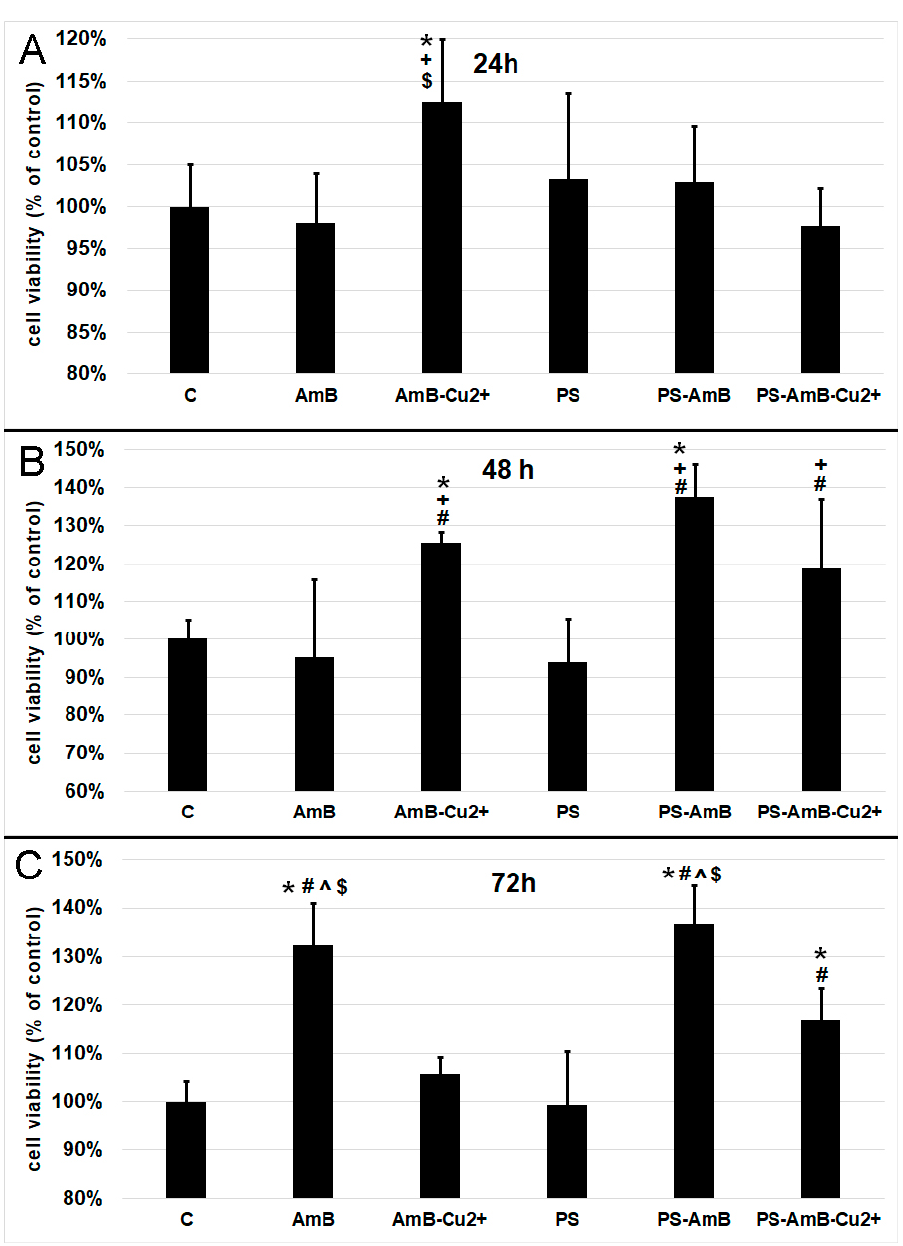
Figure 2. Cell viability based on the measurement of mitochondrial oxidative activity after exposure to the tested antibiotics and their combinations for 24 ( A ), 48 ( B ) and 72 h ( C ). The bars represent the means ± standard deviation (SD) of the percentages of the control cell viability (100%); ANOVA with the Tukey post hoc test, * p < 0.05 vs. the control, # p < 0.05 vs. PS, ^ p < 0.05 vs. AmB-Cu 2+ , + p < 0.05 vs. AmB, $ p < 0.05 vs. PS-AmB-Cu 2+ .